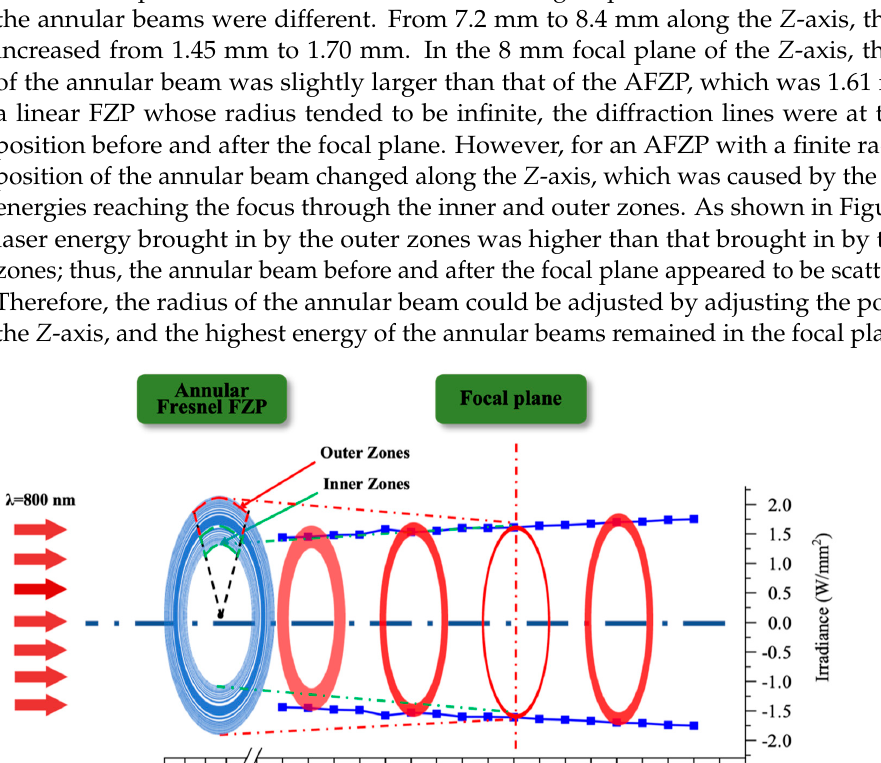
Figure 7. Simulation of the energy on the annular and central areas of the focal plane of AFZPs with different radii r 0 .